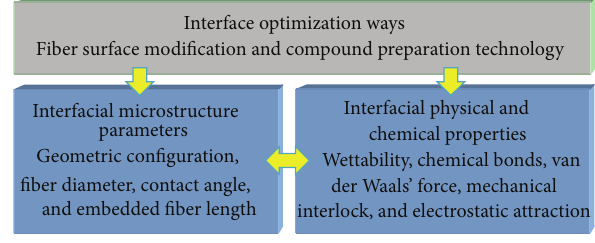
Figure 3: Evaluation tests and characterization methods for micromechanical properties of